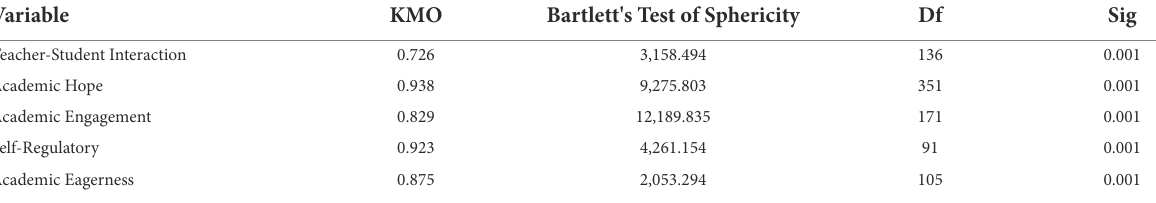
TABLE 1 KMO and Bartlett test to evaluate the adequacy of sampling and data